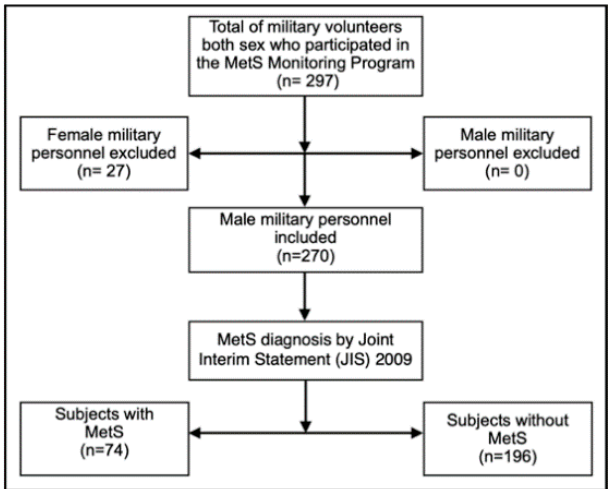
Figure 1. Schematic description of the study, with subject who participated of the Metabolic Syn- drome (MetS) Monitoring Program conducted by the Brazilian Army Physical Fitness Research Institute (IPCFEx).